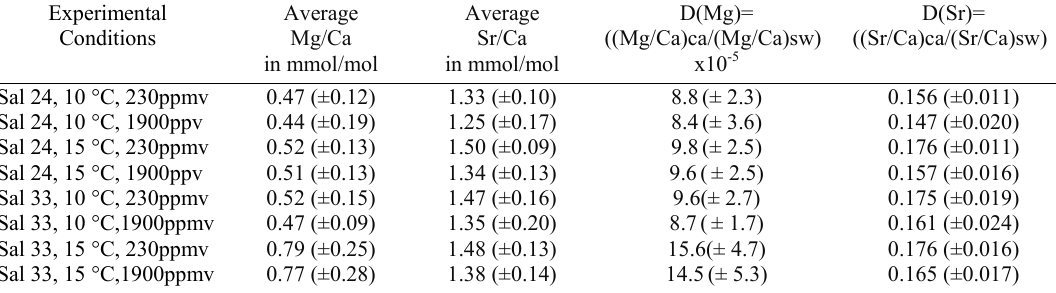
Table 4. Measured Mg/Ca and Sr/Ca ratios in foraminiferal calcite in mmol/mol and calculated distribution coefficient D ( Mg ) and D ( Sr ) for each experimental condition. Uncertainties (standard deviation (one sigma) calculated per experimental condition) are presented in brackets.